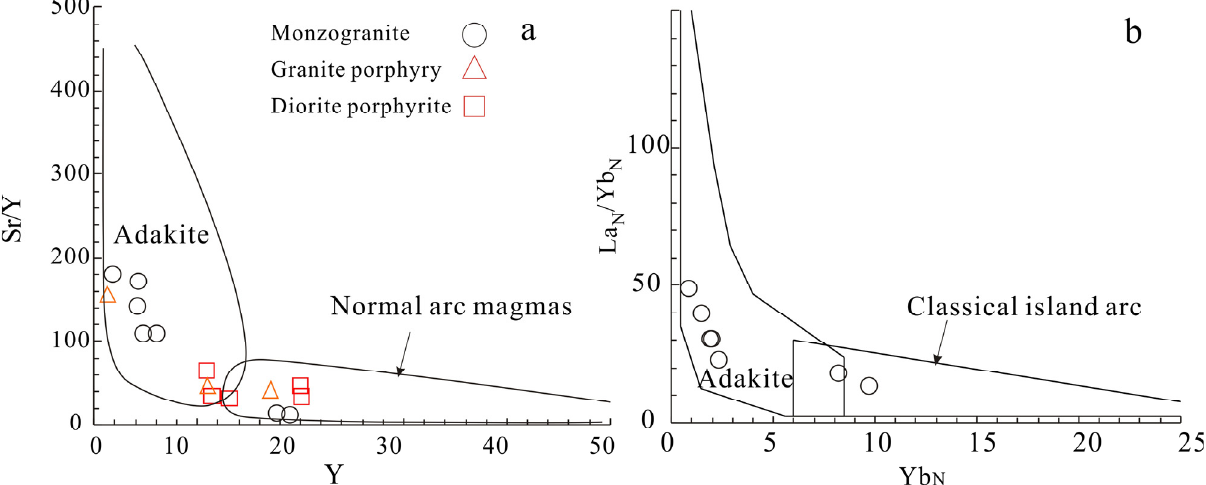
Figure 12. (Sr/Y)–Y ( a ) and (La/Yb) N –Yb N ( b ) diagrams for the Tianzishan monzogranite, granite porphyry, and diorite porphyrite dike samples (after Defant and Drummond, 1990 [95]).